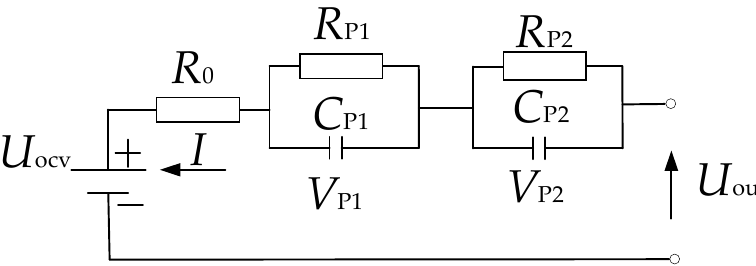
Figure 1. Second-order resistor capacitor (RC) equivalent circuit model (ECM) of a battery. I is the working current, which is positive when discharging and negative when